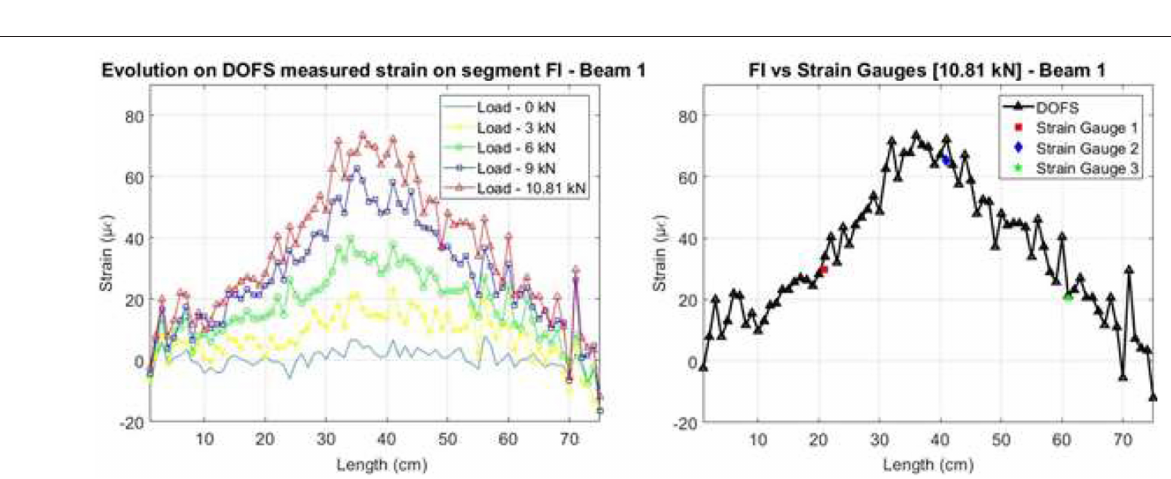
Frontiers in Built Environment | www.frontiersin.org